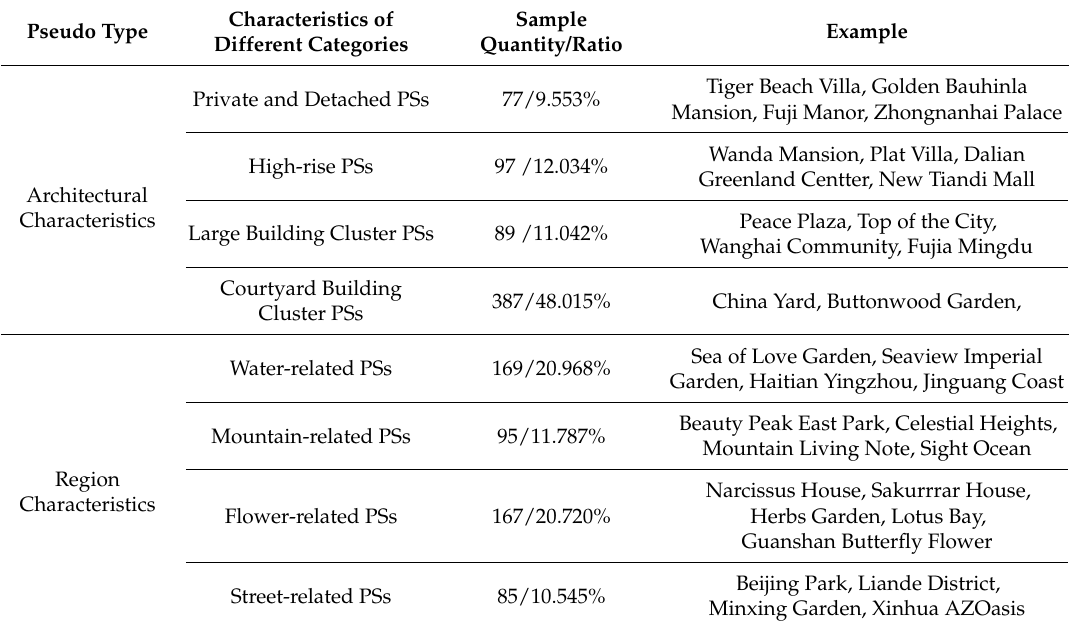
Table 3. Characteristics of pseudo-settlements in